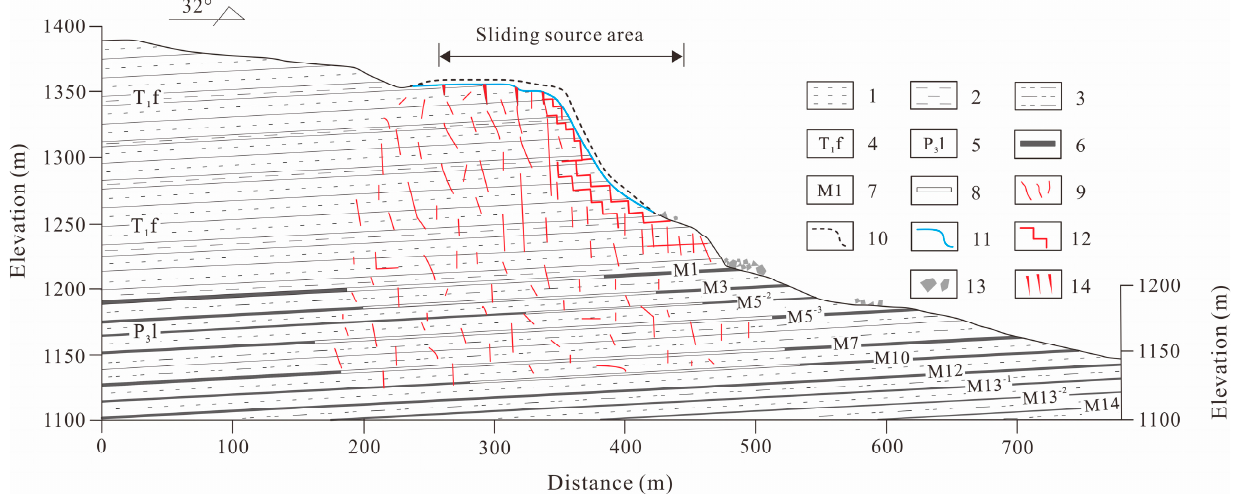
Figure 4. Geological cross-section of geological section line I-I ′ (1. sandstone; 2. mudstone; 3. argillaceous siltstone; 4. Triassic Feixianguan formation; 5. Permian Longtan formation; 6. coal seam; 7. coal seam number; 8. goaf; 9. fractures; 10. initial terrain line; 11. errain line after landslide; 12. sliding surface; 13. deposited material; 14. surface cracks). Note: the geological section line I-I ′ is marked with a purple line segment in Figure 3.